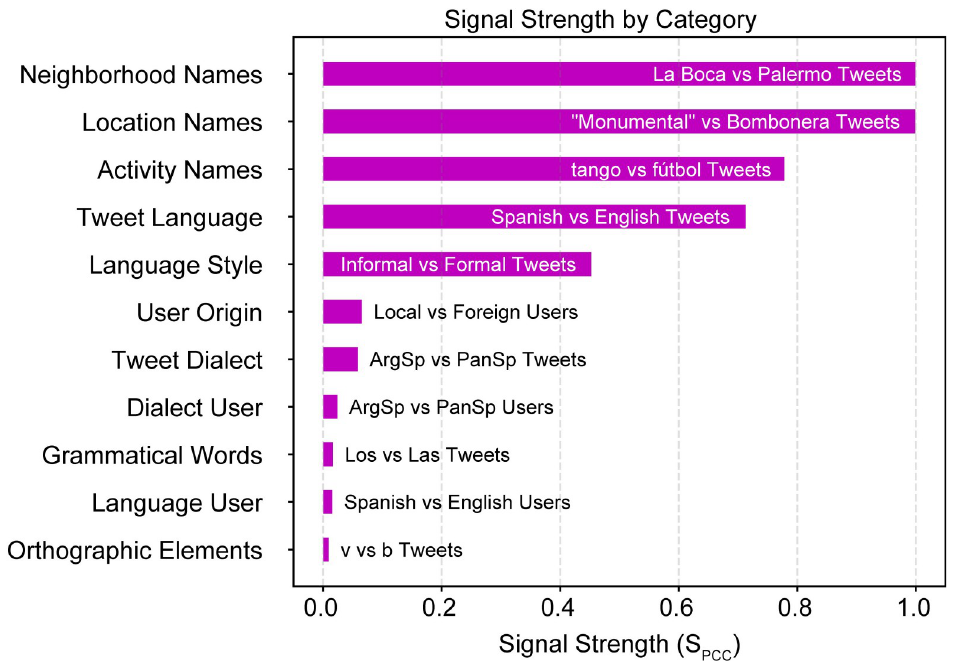
Fig 15. Bar chart of signal strength by category (case). Categories are arranged in order of decreasing signal strength (S PCC ) from top to bottom. The first two cases, Neighborhood Names and Location Names , are expected to have very strong signal strength because the token sets directly encode location information. Similarly, Orthographic Elements and Grammatical Words are expected to have weak signals because the tokens have no direct connection to location. The cases with intermediate signal strength can be shown to have varying degrees of indirectness in their connection to